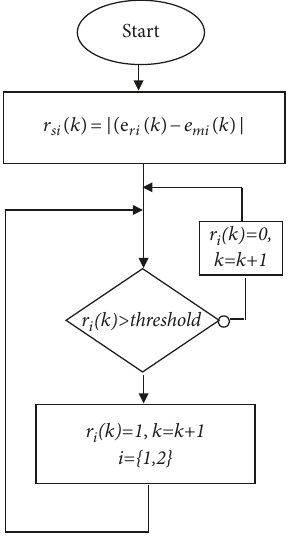
Figure 5: Flowchart of the fault detection and isolation procedure based on structural residue